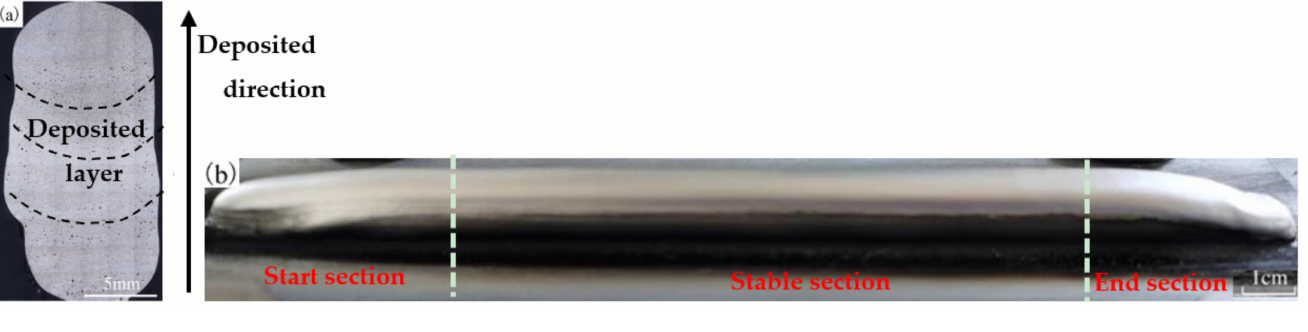
Figure 5. Cross section and morphology of deposited layer. ( a ) Deposition characteristics of deposited layer in the stable section of arc additive manufacturing. ( b ) Appearance morphology of forming characteristics of arc deposited layer. Table 2. Arc additive manufacturing process